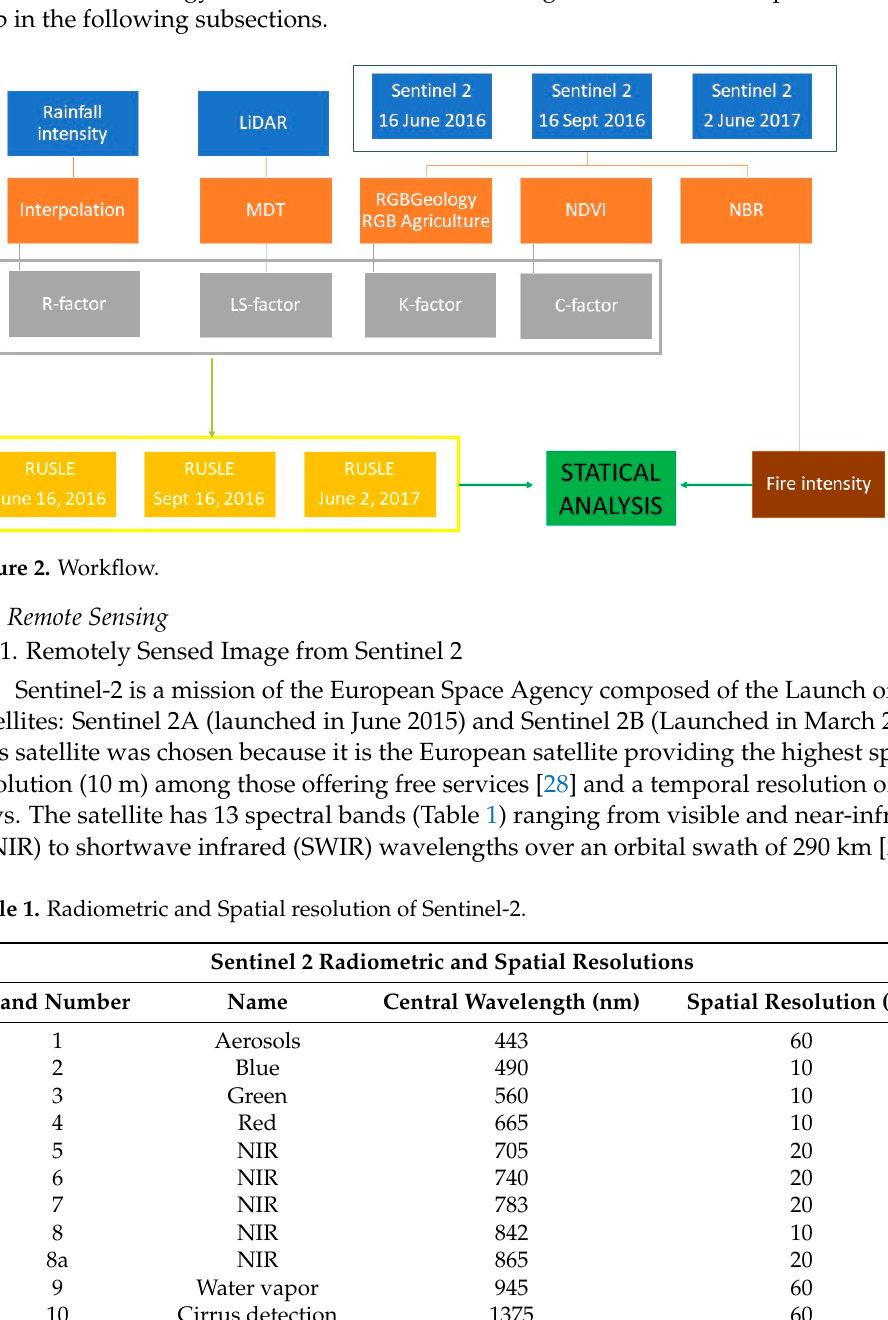
Figure 1. Situation map of Garganta de los Infiernos (Study area) of Digital Terrain Model (DTM) with the perimeter of forest fire.